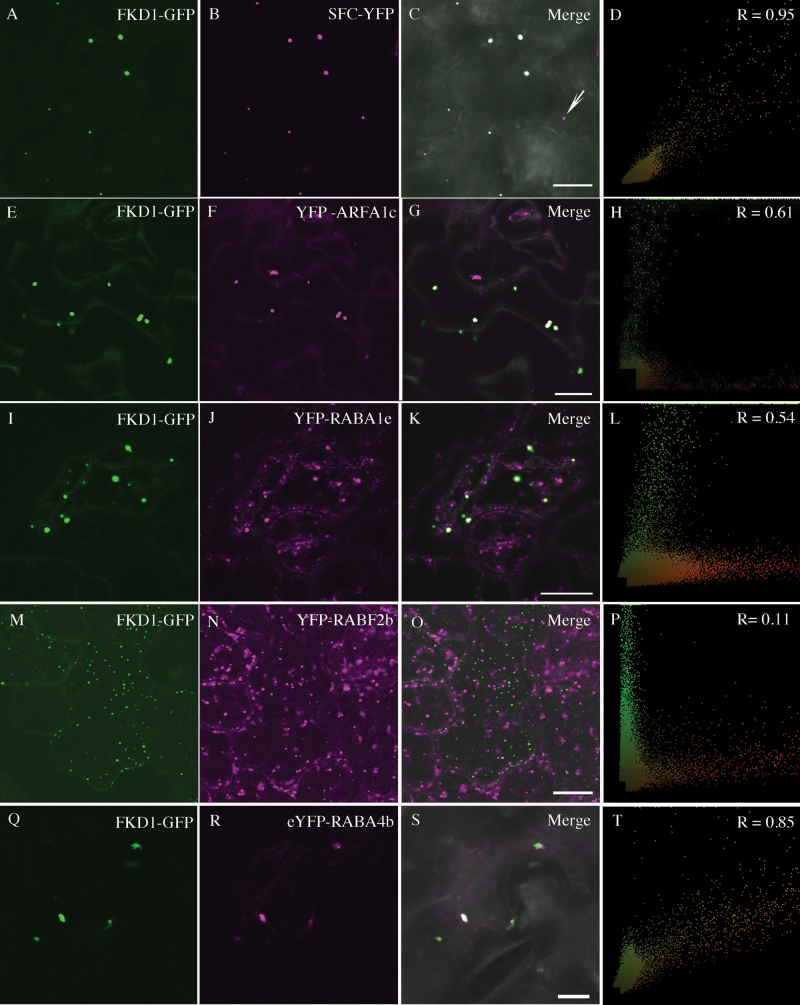
35S:FKD1–GFP localizes strongly with 35S:SFC–YFP, UBQ10:YFP–ARFA1c, and RABA–GTPases. Localization of 35S:FKD1–GFP with 35S:SFC–YFP (A–D), UBQ10:YFP–ARFA1c (E–H), UBQ10:YFP–RabA1e (I–L), UBQ10:YFP–RABF2b (M–P), or 35S:eYFP–RABA4b (Q–T) in stably transformed 2.5 DAG Arabidopsis cotyledon pavement cells (A–D and I–P) or in Nicotiana tabacum leaf epidermal cells (E–H and Q–T). (A), (E), (I), (M), and (Q) 35S:FKD1–GFP alone; (B) 35S:SFC–YFP alone; (F) UBQ10:YFP–ARFA1c alone; (J) UBQ10:YFP–RabA1e alone; (N) UBQ10:YFP–RABF2b alone; (R) 35S:eYFP–RABA4b alone; (C), (G), (K), (O), and (S) merged images; (D), (H), (L), (P), and (T) scatter plots of the merged image with Pearson’s coefficient of correlation (R) values. The arrow in (C) indicates a puncta labeled by SFC–YFP but not FKD1–GFP. Scale bar=10 μm).